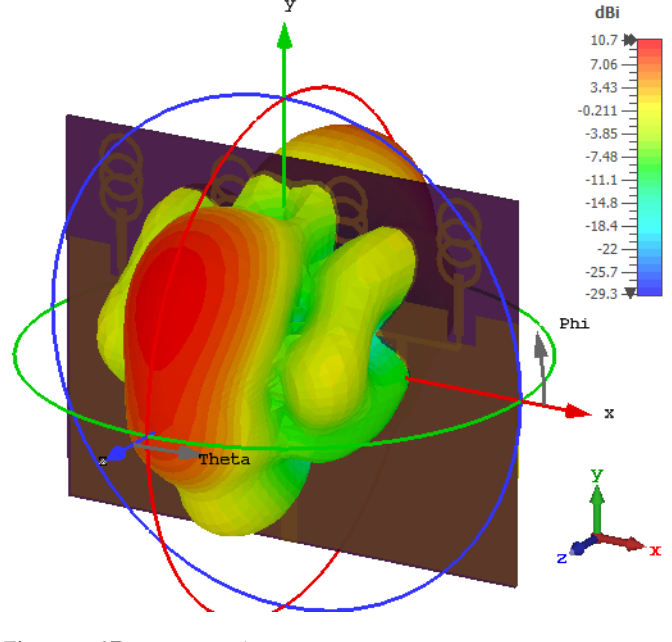
Figure 9. 3D antenna gain. Table 1. Proposed four-element array comparison with the published literature.